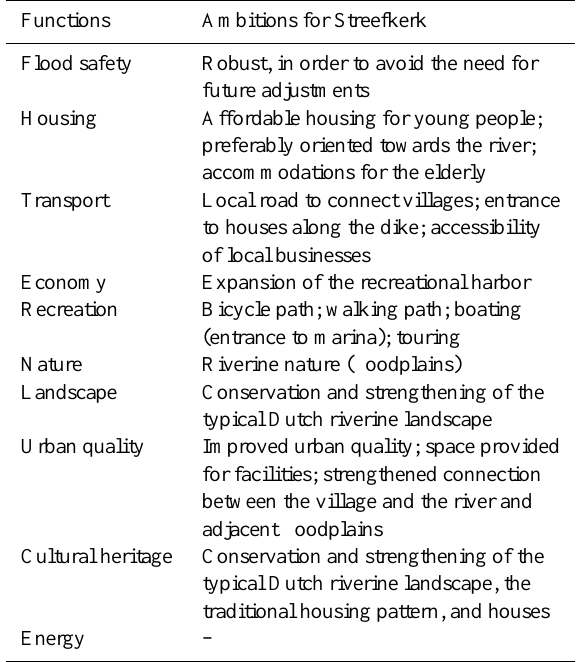
Table 3. Envisaged functions for the Streefkerk